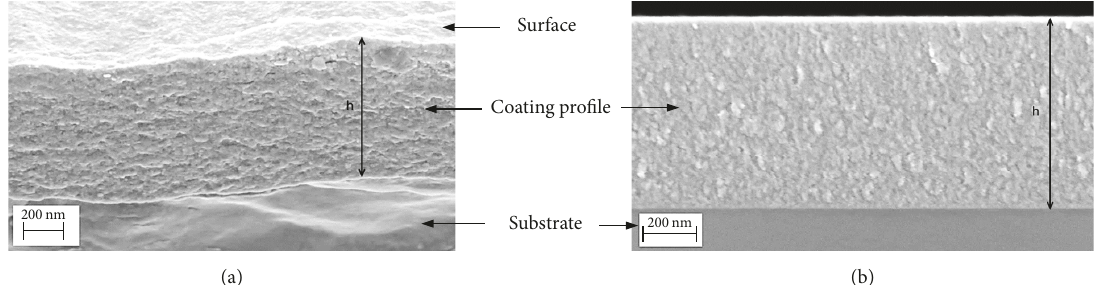
Figure 9: Cross-sectional SEM images of AlTiN coatings deposited at 300 Hz on 100Cr6-steel substrate (a) and silicon substrate (b) with film thickness ℎ = 0.744 𝜇 m.